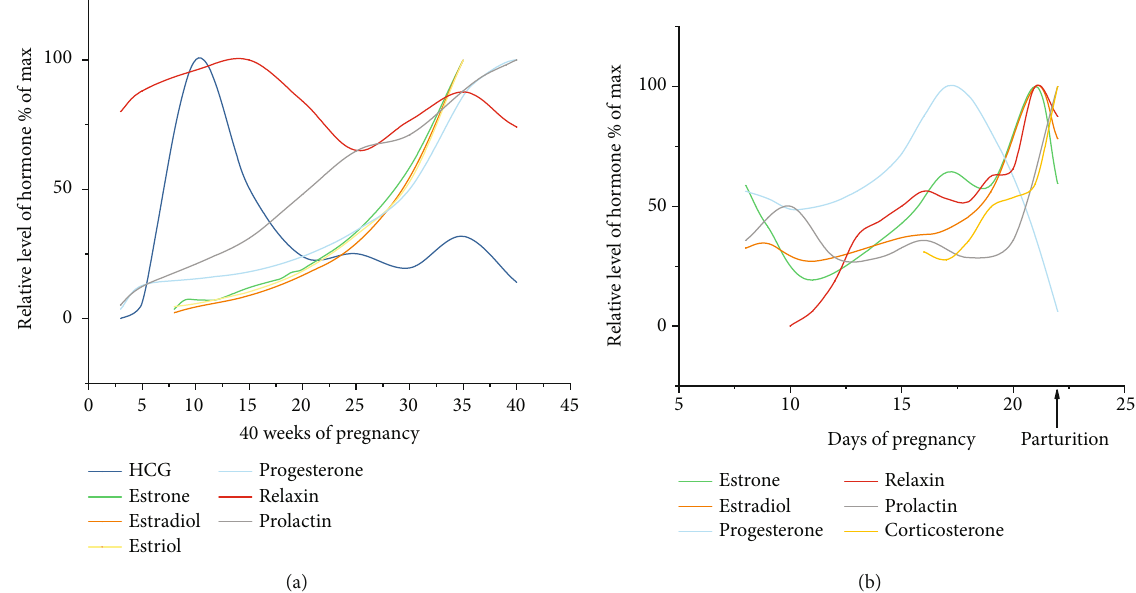
Figure 1: Schematic illustration of the changes in the levels of serum hCG [3], estrone [4], estradiol [4], estriol [4], progesterone [5], relaxin [6], and prolactin (PRL) [5, 7] during gestational weeks 6-40 in humans according to literature as indicated (the numbers in the x -axis indicate the gestational week). Blood samples were obtained through venipuncture of pregnant human females, and the diagnosis of pregnancy was con fi rmed by urine hCG determination and/or ultrasonography. HCG was determined via the double-antibody beta radioimmunoassay. Estrogens (estrone, estradiol, and estriol) were determined with an antibody against estrone-17-oxime coupled with bovine serum albumin. Progesterone was measured via the Bayer ADVIA Centaur assay. Relaxin was measured via radioimmunoassay with iodine 125-labeled polytyrosyl-relaxin and rabbit anti-porcine relaxin serum R6. PRL was determined via radioimmunoassay with homologous double antibodies. (b) Summary of the changes in the levels of estrone [8], estradiol [8], progesterone [9], relaxin [10], PRL [11], and corticosterone [12] in rat from gestational days 8-22 according to existing reports as indicated (the x -axis indicates the gestational days). The samples were derived from the peripheral blood of primiparous Sprague-Dawley rats (estrone, estradiol, progesterone, relaxin, and PRL) or the arterial blood of Wistar rats (corticosterone). Estrone and estradiol were determined via radioimmunoassay with estradiol-17 β antiserum. Progesterone was quanti fi ed by protein-binding displacement. Relaxin was measured via the interpubic ligament bioassay. PRL was determined via radioimmunoassay. Corticosterone was measured using the fl uorometric